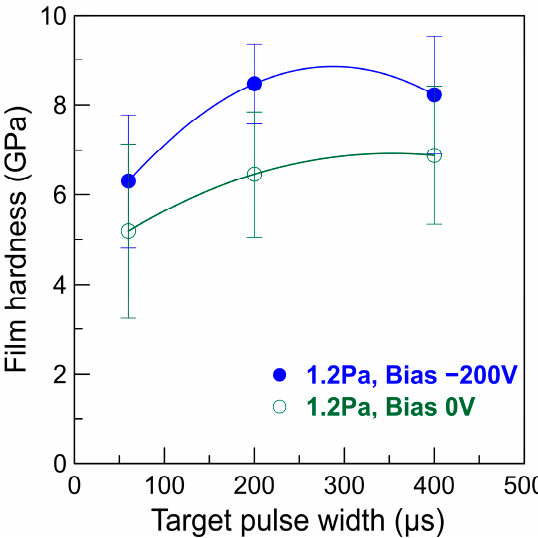
Figure 7. Film hardness versus the HiPIMS pulse width for Zr films deposited at the argon pres- sure of 1.2 Pa with and without negative substrate bias